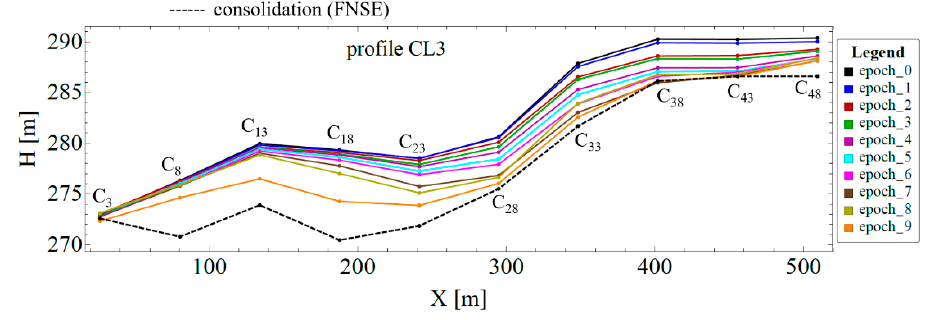
Figure 12. Calculated centroid height by profile CL3, including height at predicted consolidation using the FNSE model.